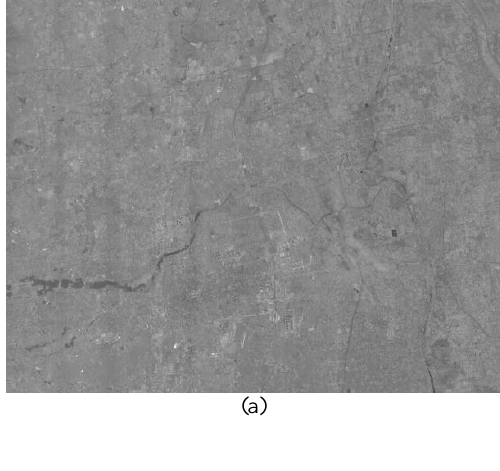
Figure 7shows the relative radiometric correction result. The proposed method removes the stripe noise,at the same time it preserves the detail(Figure 7(a)).By contrast,the processed result of moment matching method is seriously influenced by cloud,which is worse than origin image(Figure